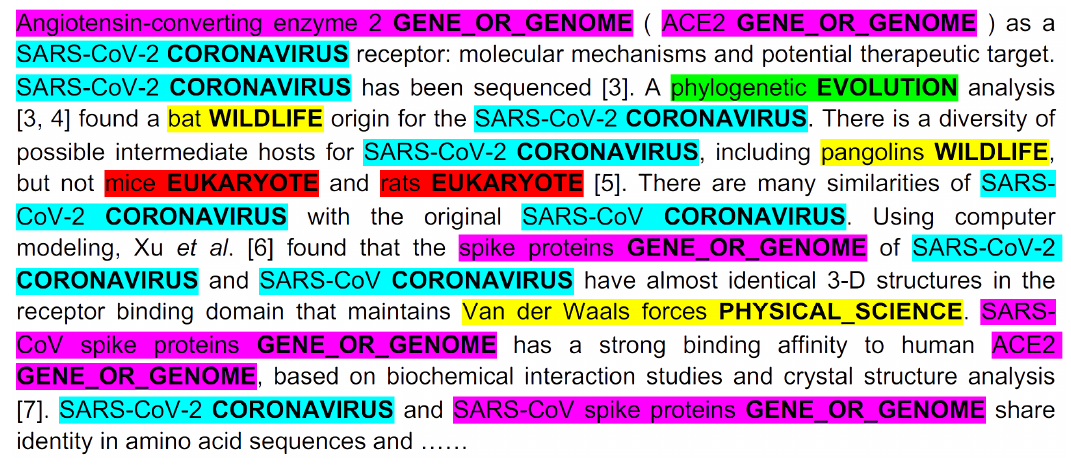
Figure 3. Example of fine-grained entity extraction. Reproduced with permission from Wang et al. [23].